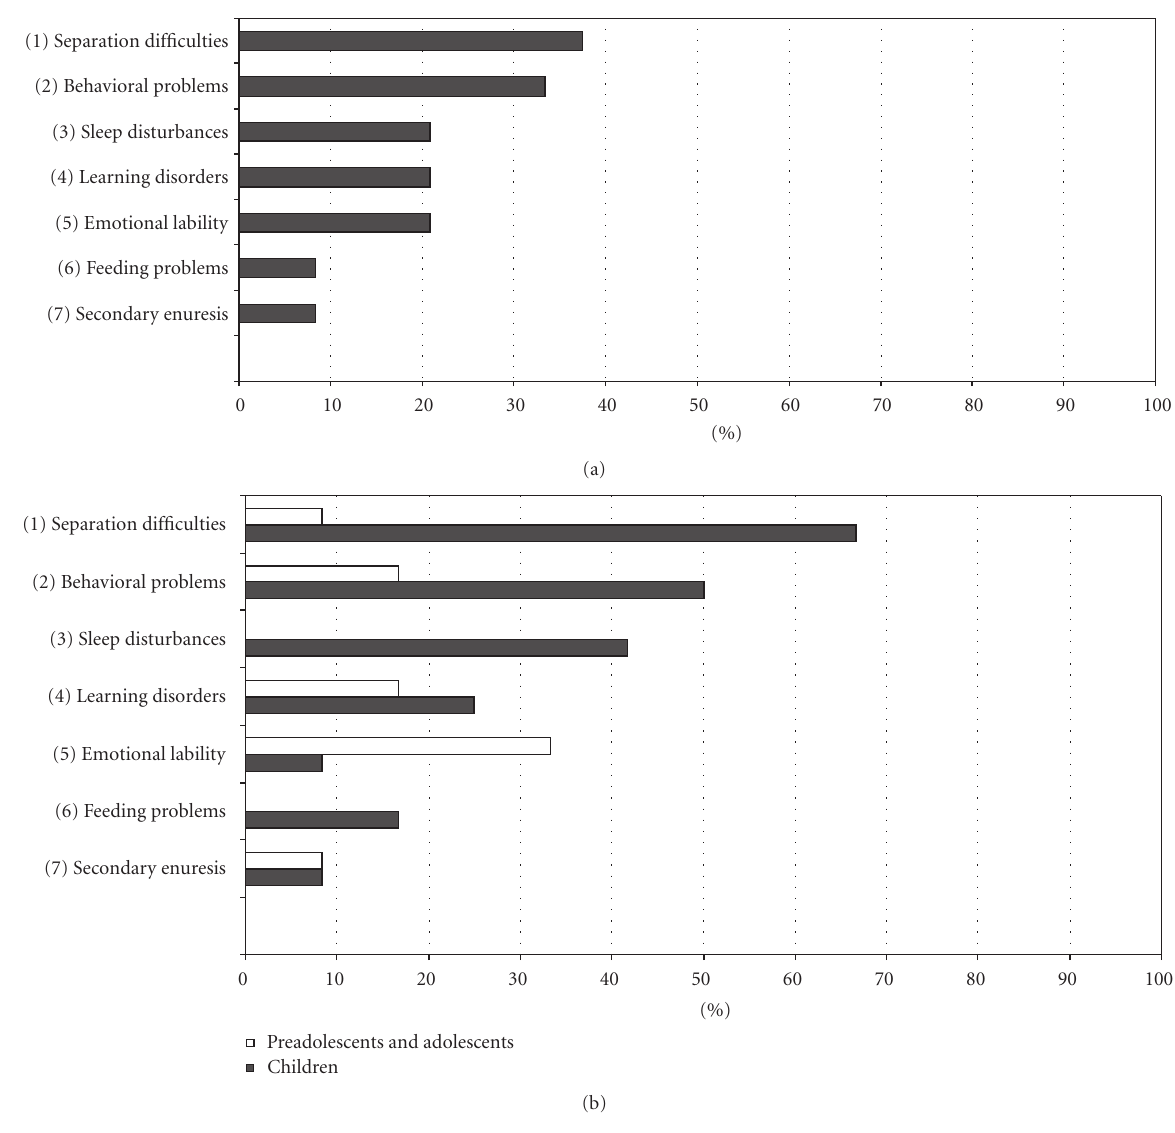
Figure 4: Psychological